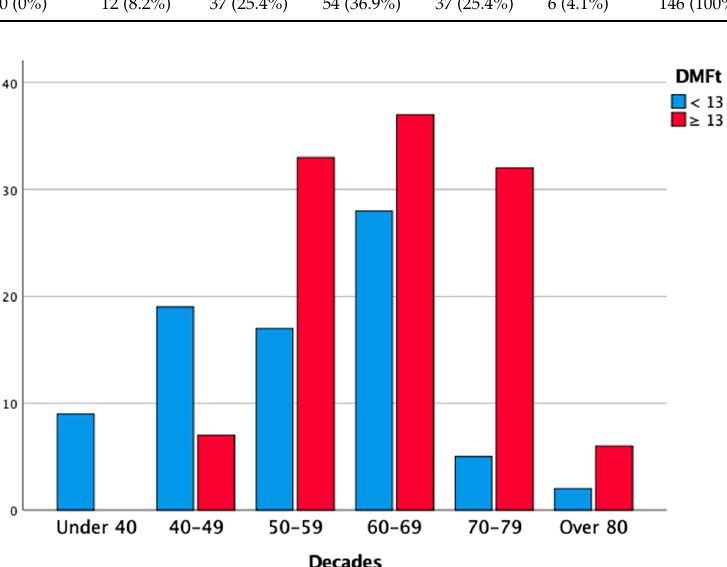
Figure 4. Distribution of periodontitis according to age of the patients (in decades).